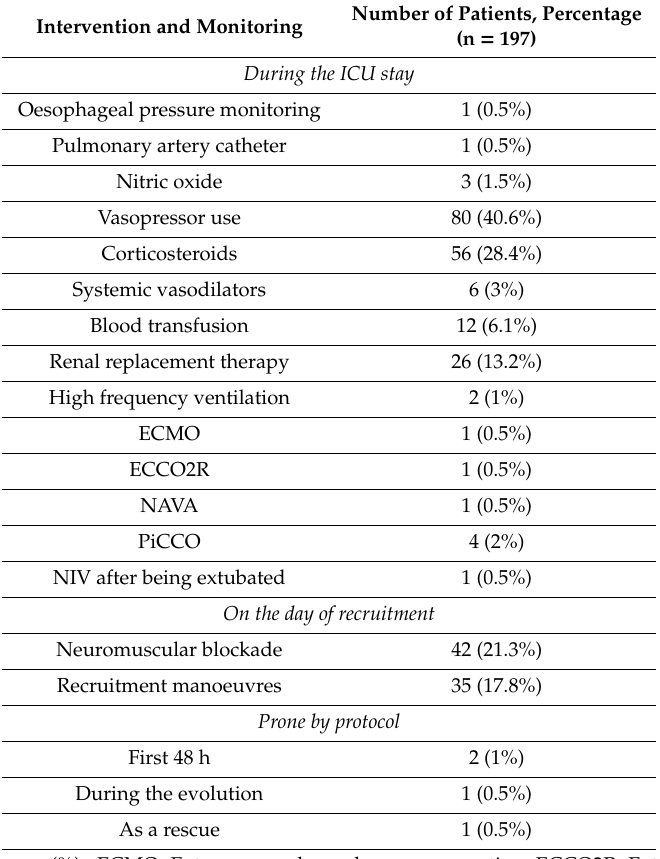
Table 3. Intervention and monitoring modalities provided to patients throughout ICU